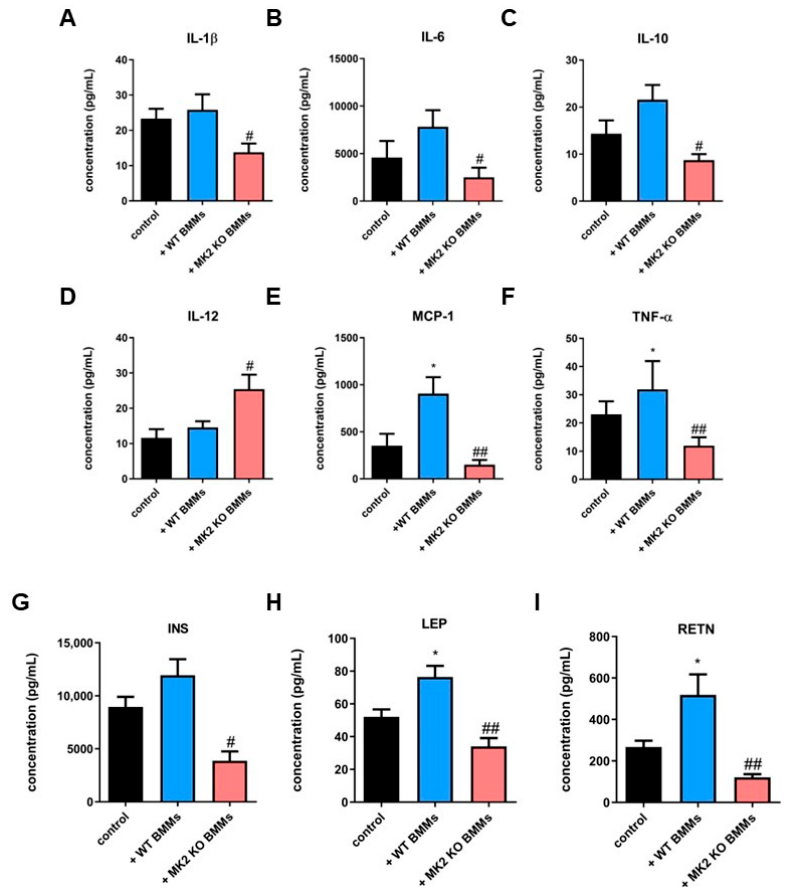
Figure 6. MK2 KO macrophages inhibit production and secretion of cytokines/chemokines and metabolic factors in PNETs. Tumor supernatants were examined by multiplex array for the con-